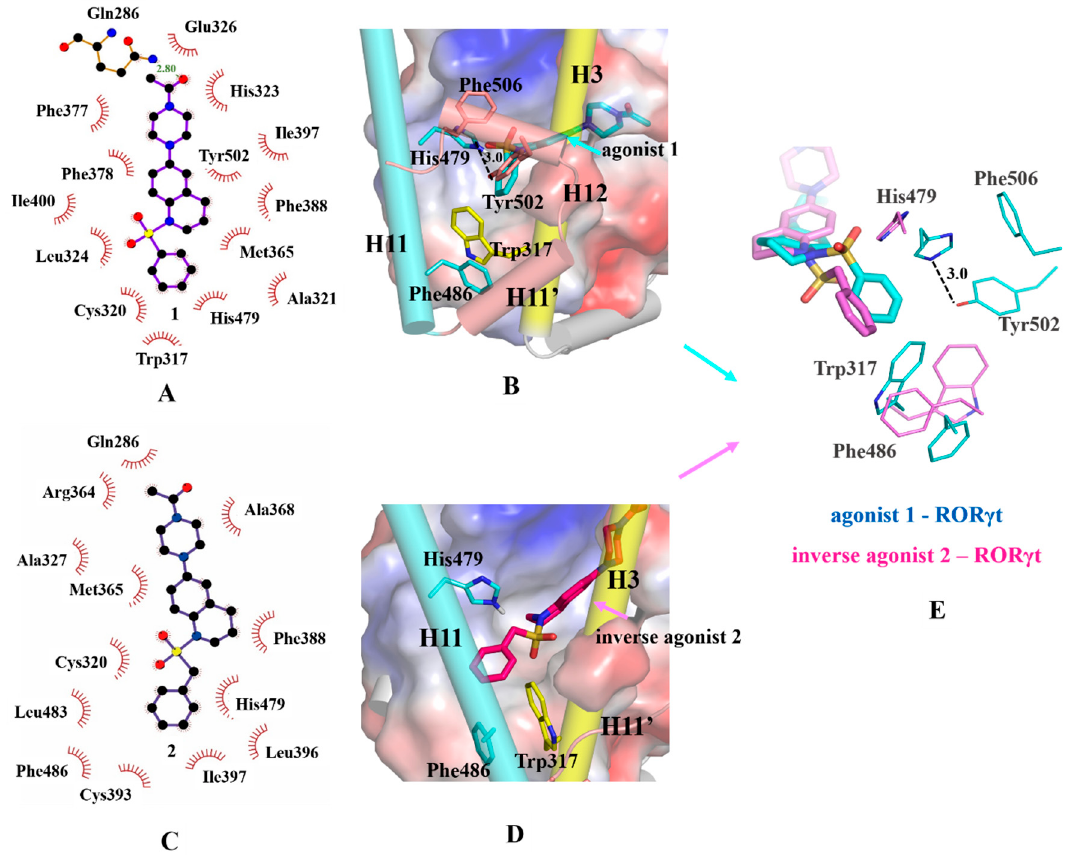
Figure 4. Binding modes of agonist 1 and inverse agonist 2 with ROR γ t-LBD. ( A , C ) 2D plot of agonist 1 -ROR γ t and inverse agonist 2 -ROR γ t. ( B , D ) 3D docking models of agonist 1 -ROR γ t-LBD and inverse agonist 2 -ROR γ t-LBD. The active site was represented as an electrostatic surface. The important residues in the active site were rendered in stick representation. Trp317 (from H3) and H3 were in yellow. His479 (from H11), Phe486 (from H11) and H11 were in cyan. Tyr502 (from H11), Phe506 (from H12), H11 ′ and H12 were in salmon. Agonist 1 shown as blue, inverse agonist 2 shown as magenta. E , overlay of agonist 1 and inverse agonist 2 in ROR γ t. Agonist 1 and residues in agonism state were shown as blue, inverse agonist 2 and residues in inverse agonism state were shown as magenta. The hydrogen bond interactions are represented as dashed lines and the distances are labeled.